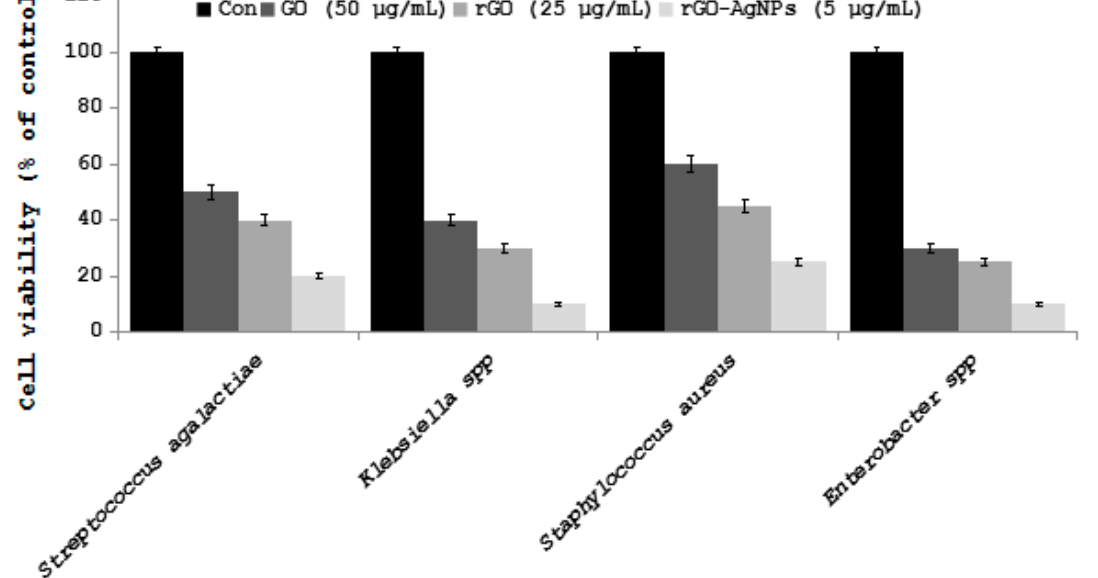
Figure 9. Effect of graphene oxide (GO), reduced graphene oxide (rGO), and GO-Ag on cell survival of Staphylococcus agalactiae , Klebsiella spp., Staphylococcus aureu and Enterobacter spp. Streptococcus agalactiae , Klebsiella spp., Staphylococcus aureu , and Enterobacter spp. cells were incubated with GO (100 µ g/mL) rGO (50 µ g/mL), and rGO-Ag (10 µ g/mL). Bacterial survival was